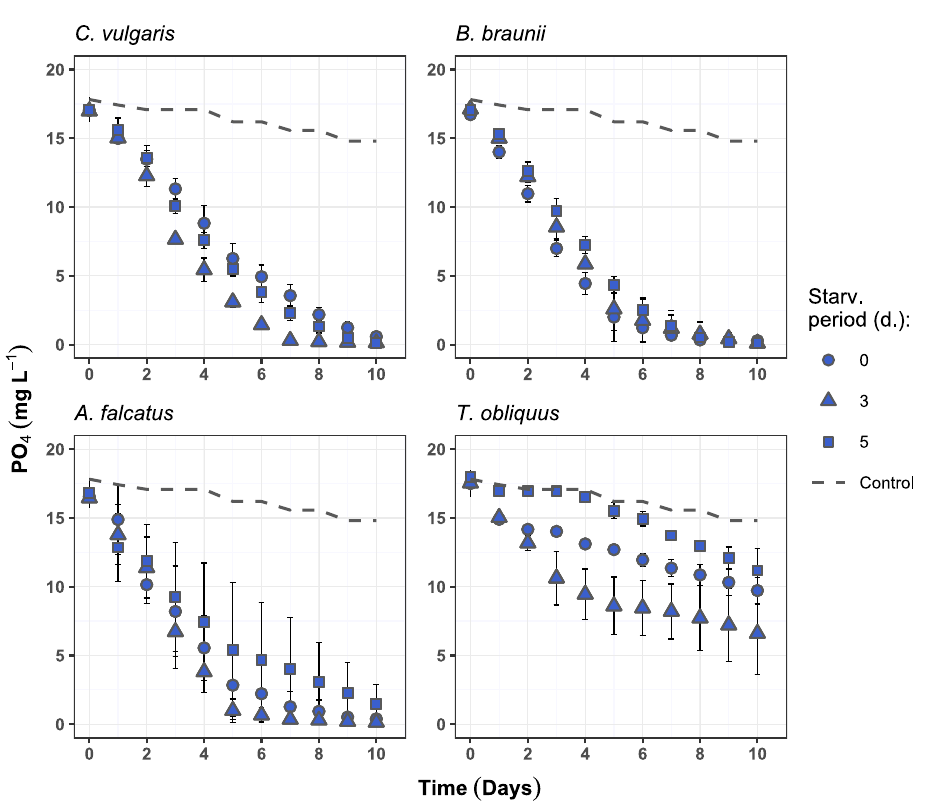
Figure 4. Phosphate concentration changes over time in the experiment batches for C. vulgaris, B. braunii, A. falcatus, and T. obliquus (means ± SD, n = 3).